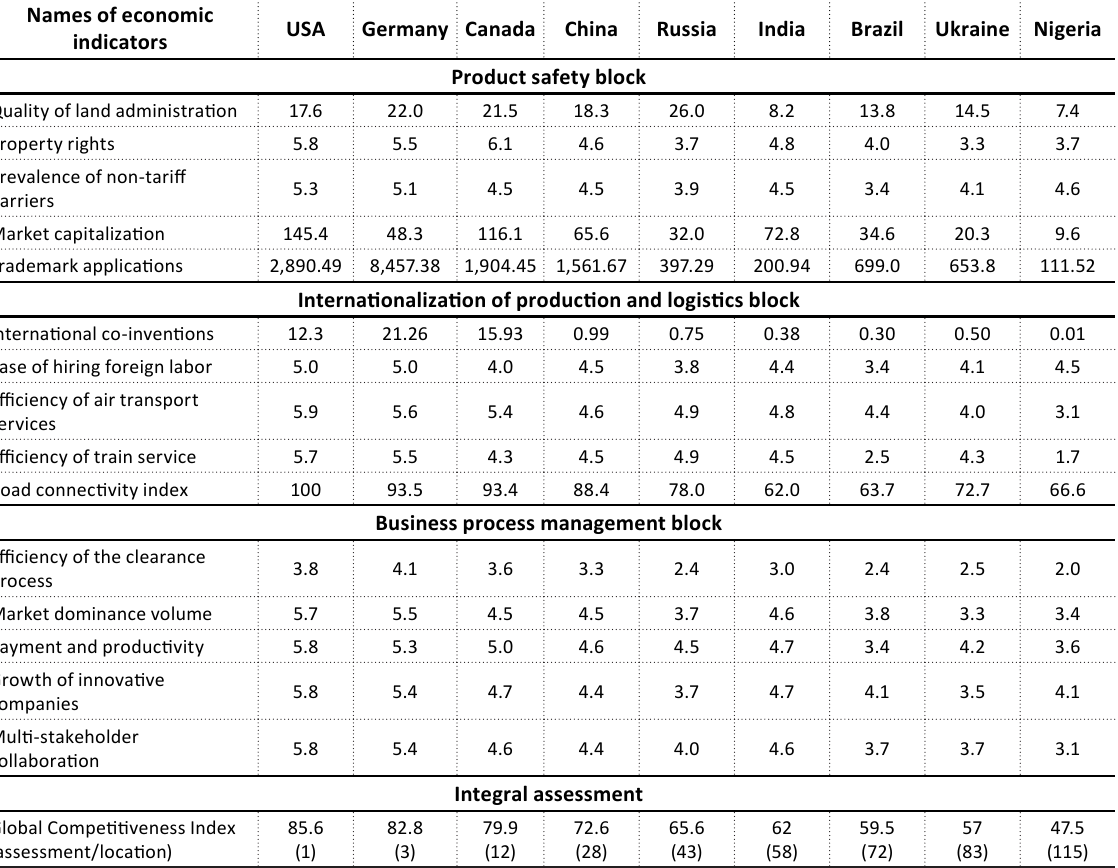
Source: Based on Simpson (2012), Schwab